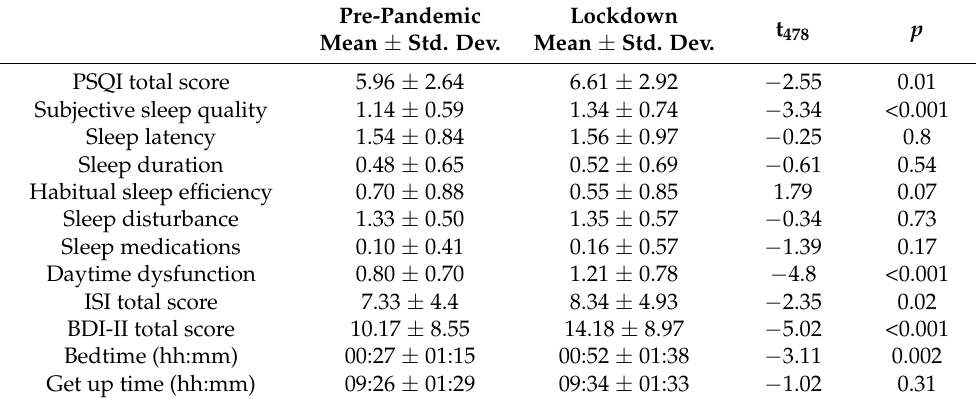
Table 1. Mean ± standard deviation of questionnaire scores (PSQI, ISI, BDI-II), PSQI sub-components, bedtime, and get up time of the two groups (pre-pandemic, lockdown). Results of t -test comparisons are also reported (t degrees of freedom , p ).